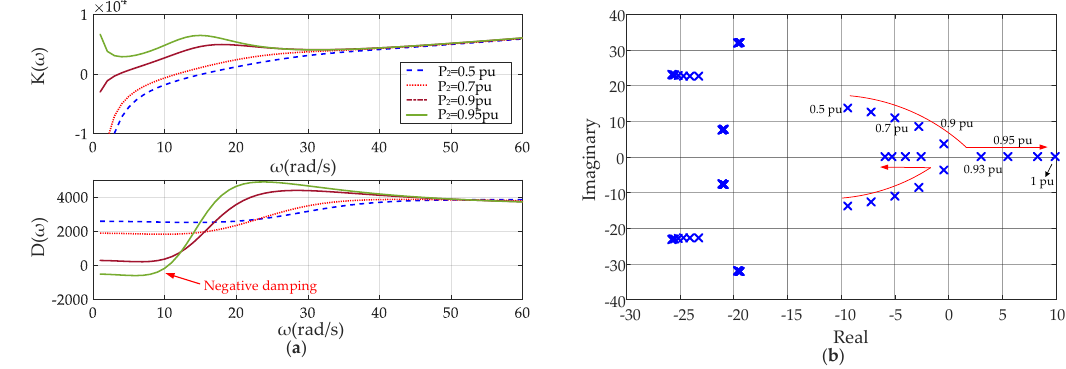
Figure 11. ( a ) Frequency response curves of spring and damping coefficients under different VSC2 power outputs when AVC of VSC1 and VSC2 is not included; ( b ) corresponding eigenvalue locus.